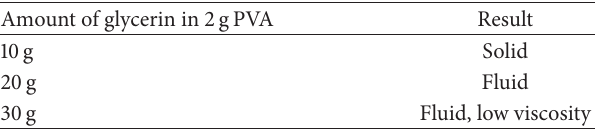
Table 3: Optimization of PVA-glycerin mix ratio in “ Paste 1.